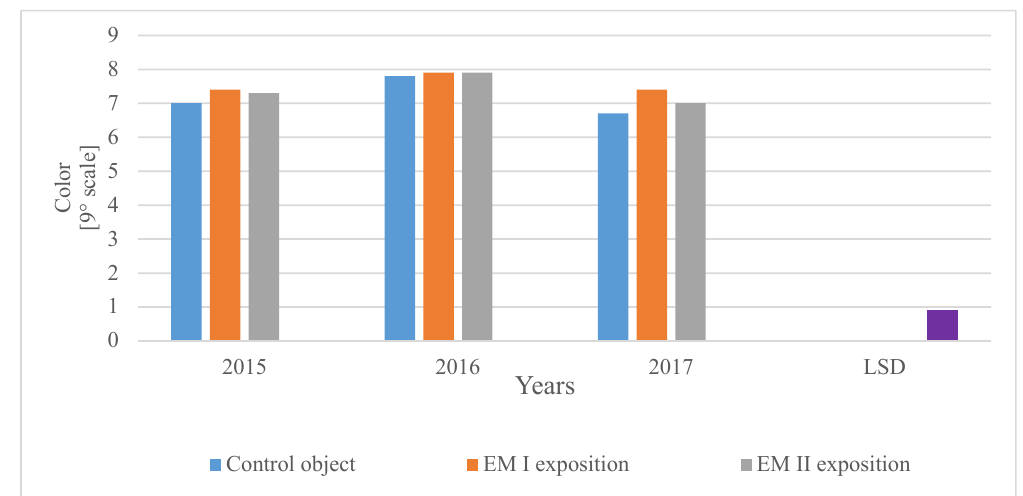
Figure 2. Influence of EM technology and meteorological conditions in the years of research on the color of PC. The features of individual varieties determined the value of PC to the greatest extent. golden color. The following varieties turned out to be homogeneous in terms of the value